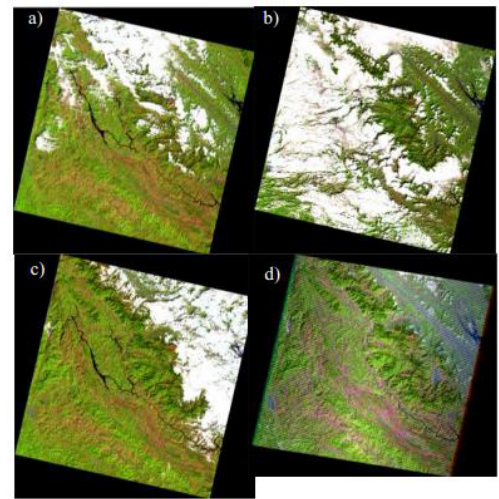
Figure 2. Landsat scenes show complexity of cloud cover in the study area for months of January and February of year 2017. Colour composite is RGB:654 for Landsat 8 and RGB:543 for Landsat 7. Observation date is Jan. 13, 2015 for a); Jan. 29, 2015 for b); Feb. 19, 2017 for c) and Jan. 28, 2006 for d).